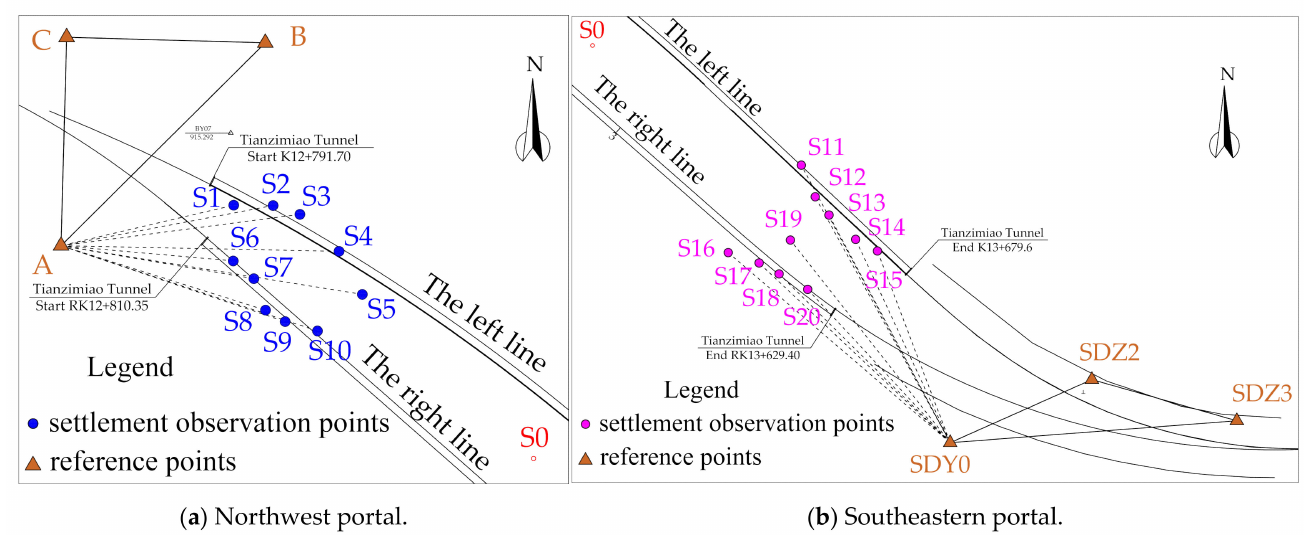
Figure 7. Layout of mountain surface settlement observation